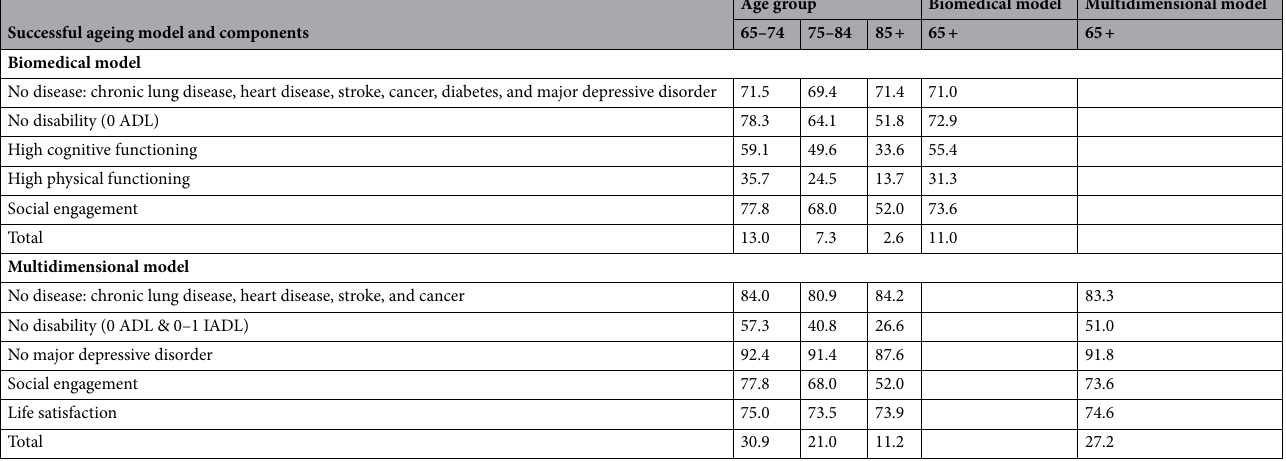
Table 2. Successful ageing by biomedical and multidimensional model.